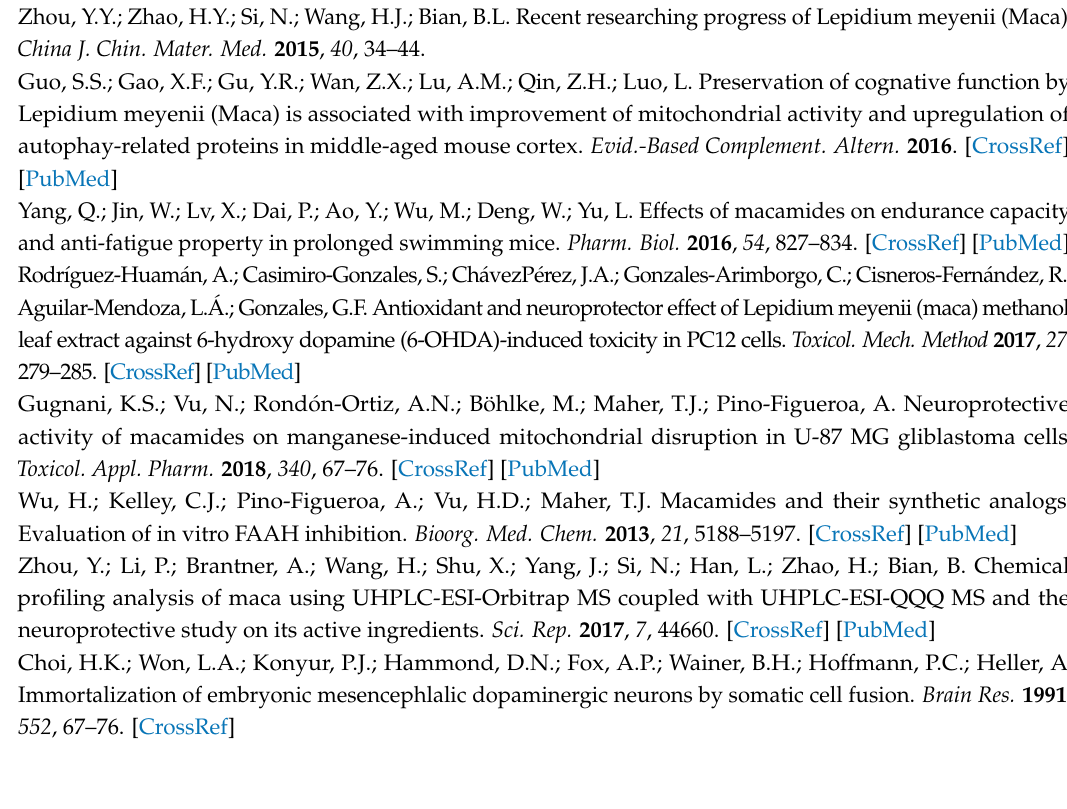
Supplementary Materials: The following are available online, Figure S1: The absolute quantification results of neurotransmitters ((Ax/Ai) × 100, n = 3,* p < 0.05, ** p < 0.01: VS controlgroup; # p < 0.05, ## p < 0.01: VS model group), Figure S2: The relative quantification results of neurotransmitters ((Ax/Ai) × 100, n = 3, * p < 0.05, ** p < 0.01: VS control group; # p < 0.05, ## p < 0.01: VS model group Y-axis: (Ax/Ai) × 100. Table S1: The results of precision, repeatability and stability, Table S2: 142 were upregulated and 209 were downregulated after XA treatment, Table S3: Validation of some differential lipids, Table S4: Validation of 4 differential proteins Author Contributions: Y.Z. performed the experiments and H.Z. and F.G. assisted in data analyses. Y.Z. analyzed the data and wrote the paper. B.B., H.Z., and A.B contributed to the study design and overall supervision. H.W., J.Y., N.S., X.W., and L.H. discussed the results and commented on the manuscript. All the authors reviewed the